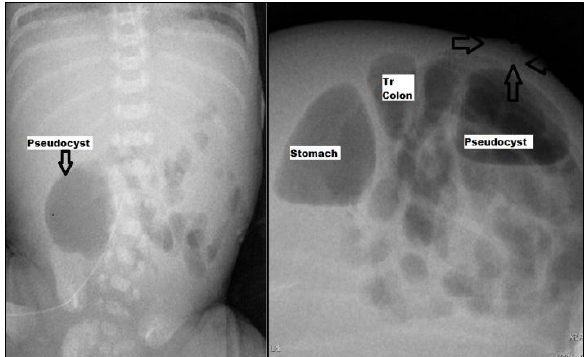
Figure 2: Delayed Abdominal film showing persistence of air pocket and decubitus showing air in collar stud